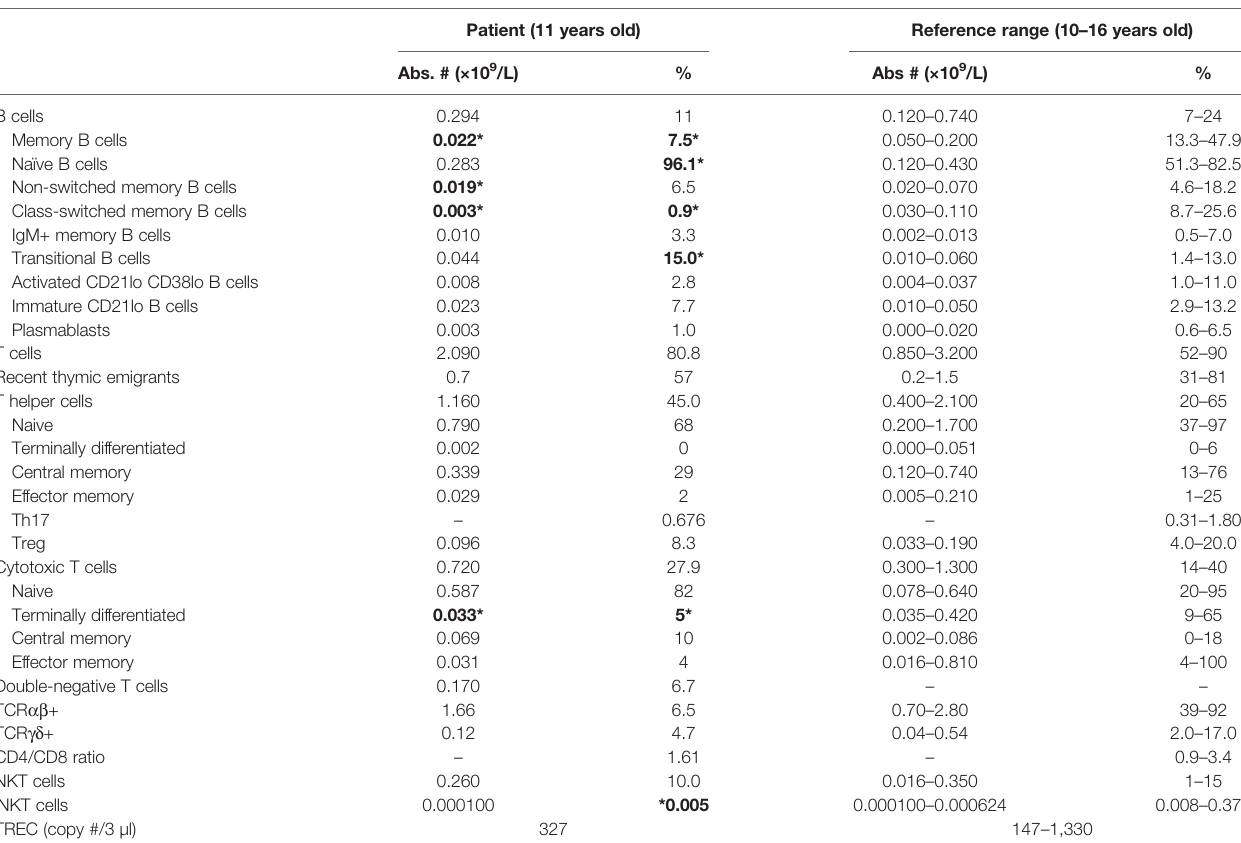
TABLE 2 | Patient laboratory values.